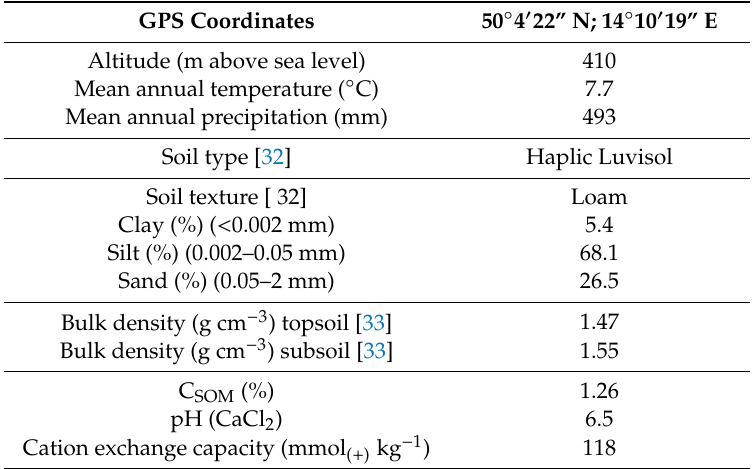
Table 4. Basic description of investigated location; C SOM —soil organic matter